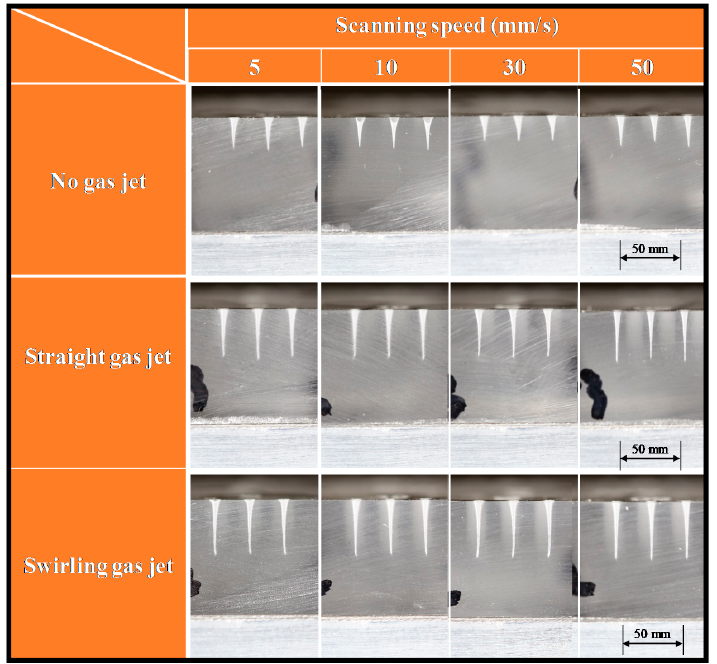
Figure 12. Profile images of drilled holes with different gas jet configurations (no gas jet, straight gas jet, and swirling gas jet) at different laser scanning speeds.